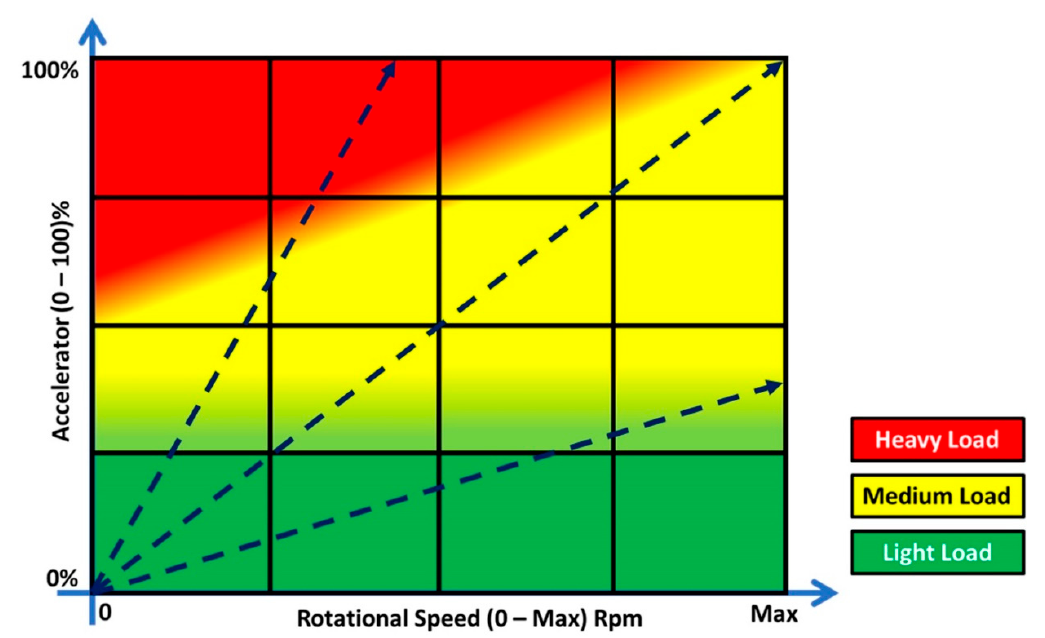
Figure 7. Load characteristics in an electric vehicle.